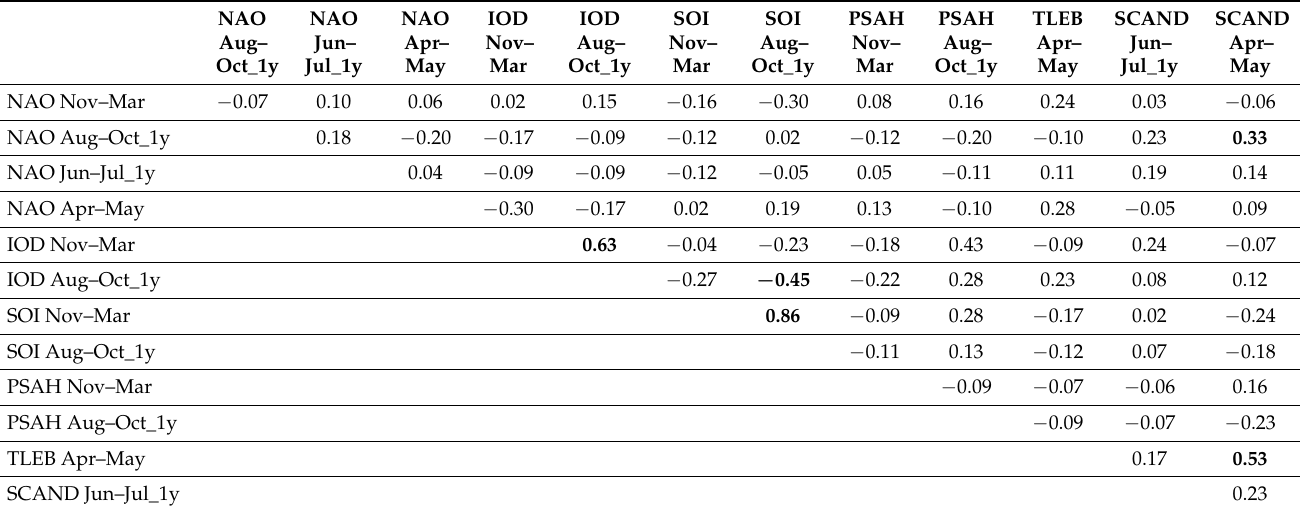
Table A4. Pearson’s correlation coefficients of climate indices in 1981–2017 used in multiple regression models. Abbreviations of the climate variables as in Table 1; “_1y” = climate indices from the year preceding the spring being analysed. Significant correlations after Benjamini–Hochberg correction for multiple comparisons with accepted 5% level of false positives marked in bold